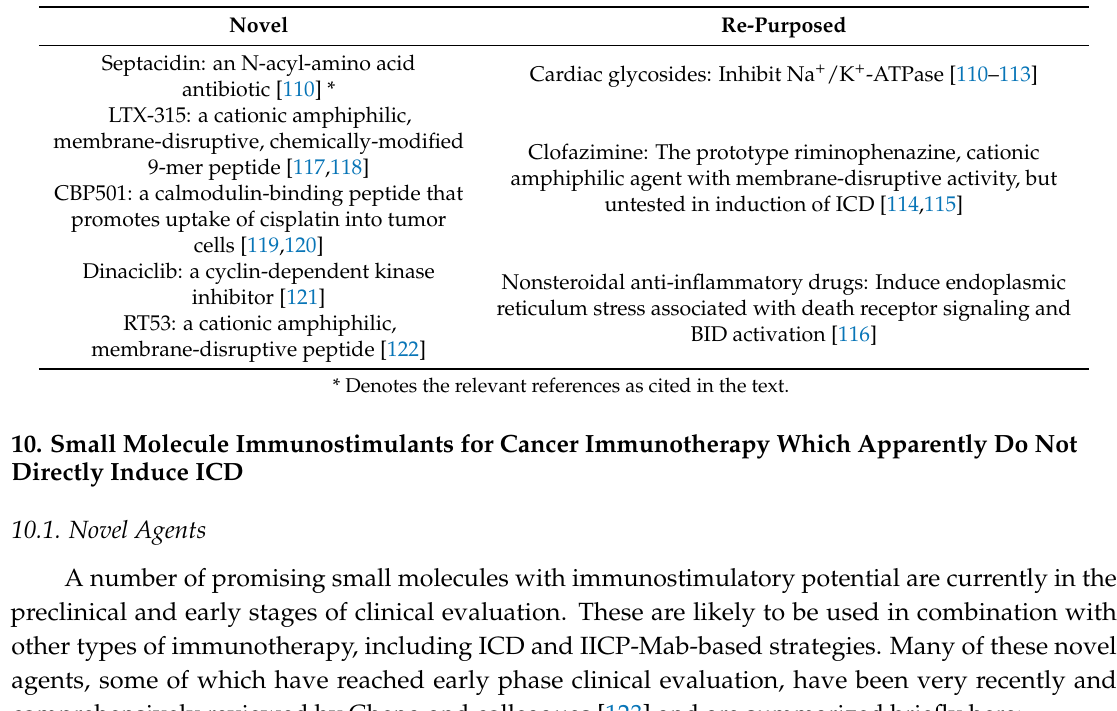
Table 4. Novel and “re-purposed” inducers of immunogenic cell